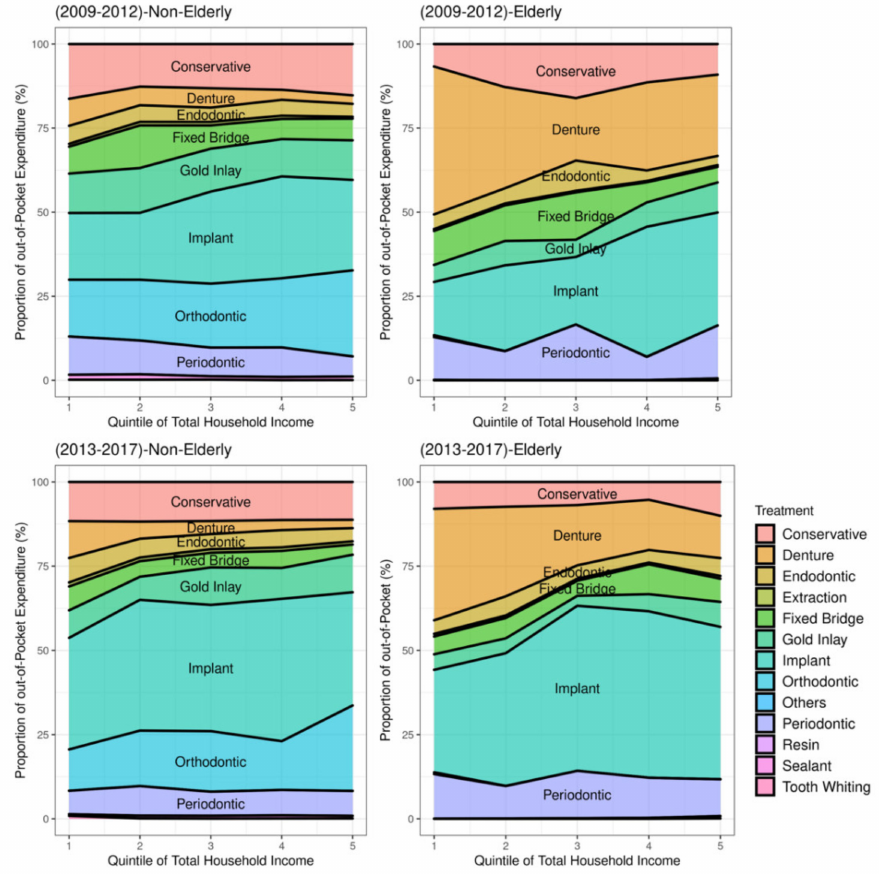
Figure 2. Changes in dental use behavior as a percentage of annual out-of-pocket expenses by period. If the total cost of some treatment areas, such as resin filling, extraction, and tooth whiting, was relatively small, it is not shown in the